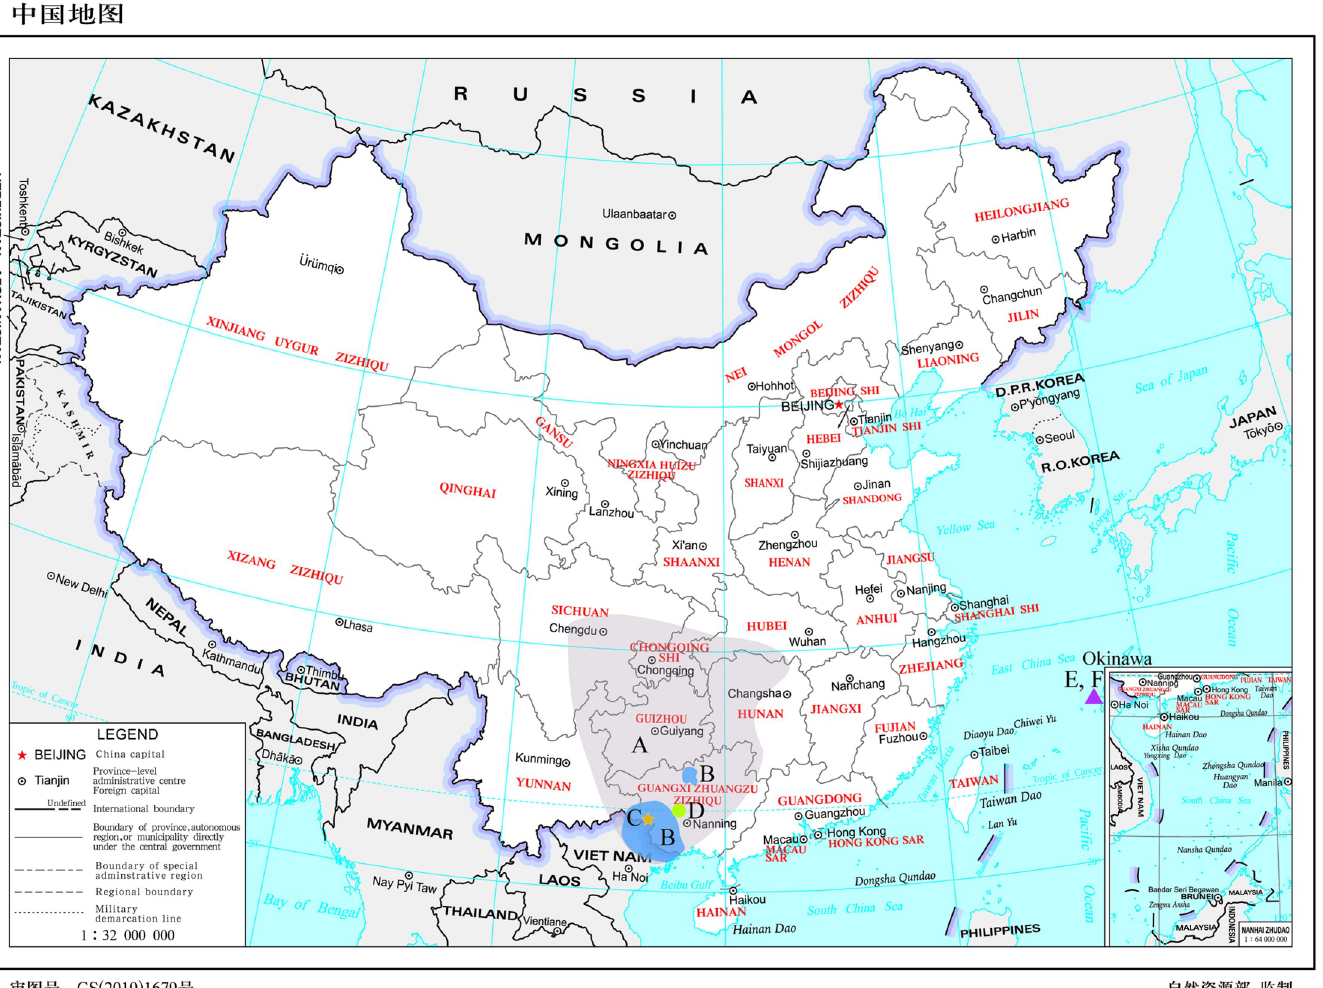
Fig 1. Distributional ranges of Tonkinacris spp . A. T . sinensis . B. T . decoratus . C. T . meridionalis . D. T . damingshanus . E, F. T . ruficerus and T . yaeyamaensis (The ground map was reprinted from Standard Map Service (http://bzdt.ch.mnr.gov.cn) under a CC BY license, with permission from the Ministry of Natural Resources